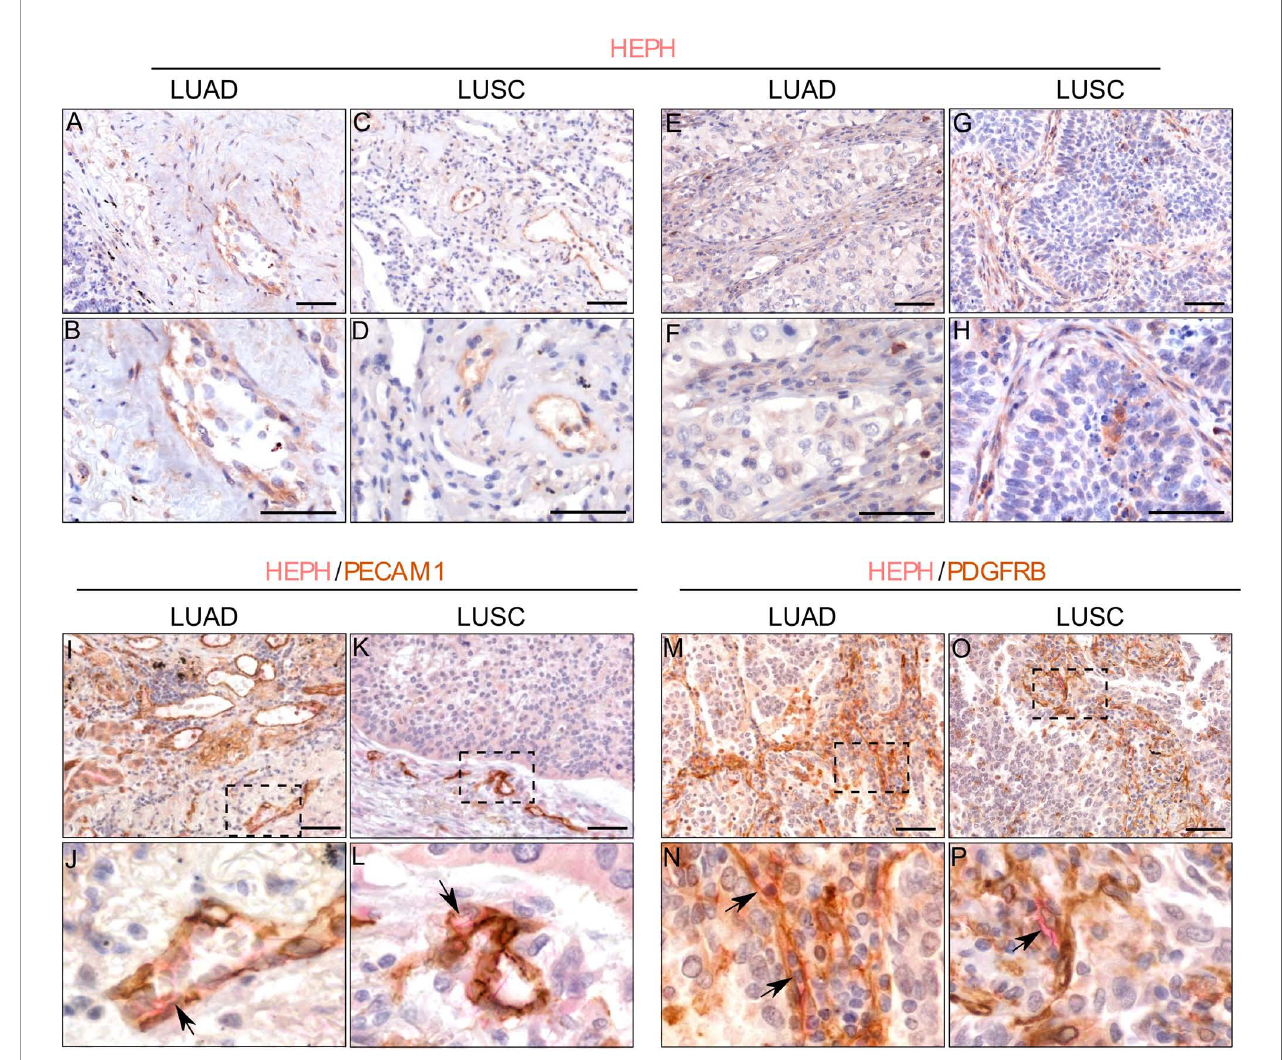
FIGURE 6 | HEPH expression by endothelial and stromal cells in LUAD and LUSC specimens. Endothelial cells identi fi ed morphologically in single HEPH immunostaining (panels (A, B) for LUAD and (C, D) for LUSC), and by way of the strong expression of PECAM1 (CD31) upon double-labeling (panels (I, J) for LUAD and (L, M) for LUSC). Black arrows indicate HEPH/PECAM1 colocalization. Fibroblasts identi fi ed based on their spindle-shaped morphology in single HEPH immunostaining [panels (E, F) for LUAD and (G, H) for LUSC], and by the expression of PDGFR- b upon double-labeling. Back arrows indicate HEPH/PDGFR- b colocalization [panels (M, N) for LUAD and (O, P) for LUSC]. Panels (J, M, N, P) represent higher magni fi cations of the corresponding dashed area indicated on the corresponding upper panel. Polymer detection system with AEC (red) chromogen for HEPH and DAB (3,3 ′ -Diaminobenzidine) chromogen for PECAM1; scale bars, 50